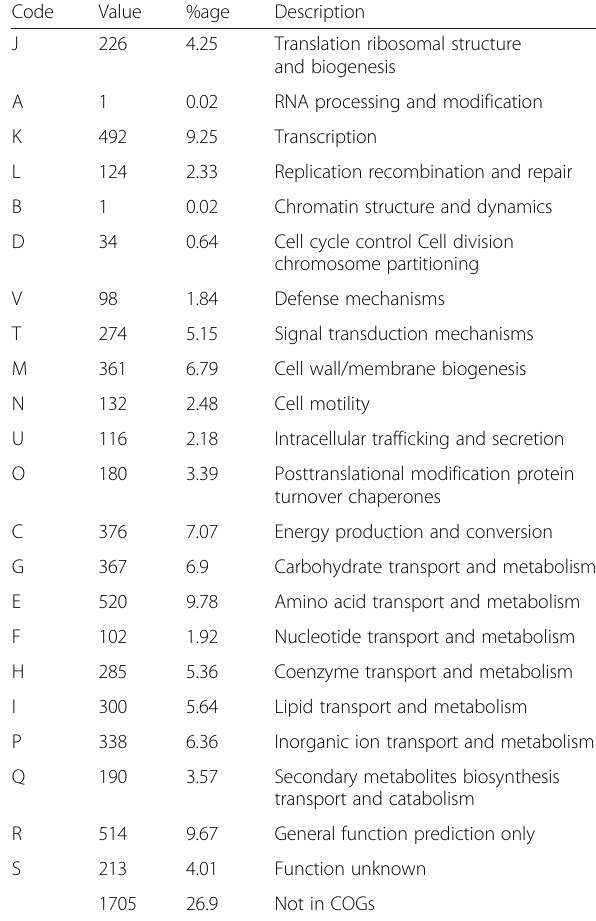
Table 4 Number of genes associated with general